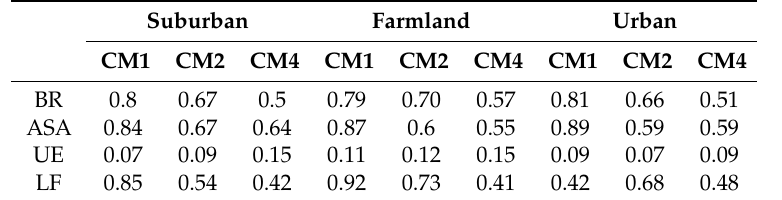
Table 2. The quantitative evaluation of over-segmentations using the ddCRP over three type of geo-scenes, i.e., Suburban (S), Farmland (F), and Urban (U) areas, under three kinds of connection modes, i.e., one-connection mode (CM1), two-connection mode (CM2), and four-connection mode (CM4), respectively. For every evaluation metric, the best performance among different connection modes was marked as red or blue bold.